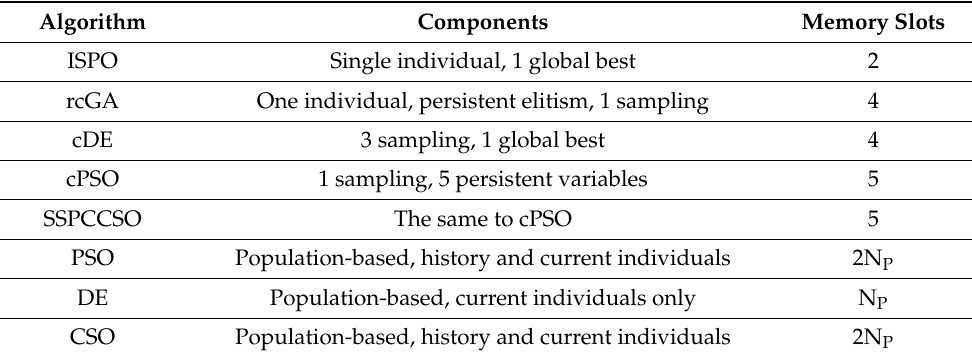
Table 2. Running memory space for all compared